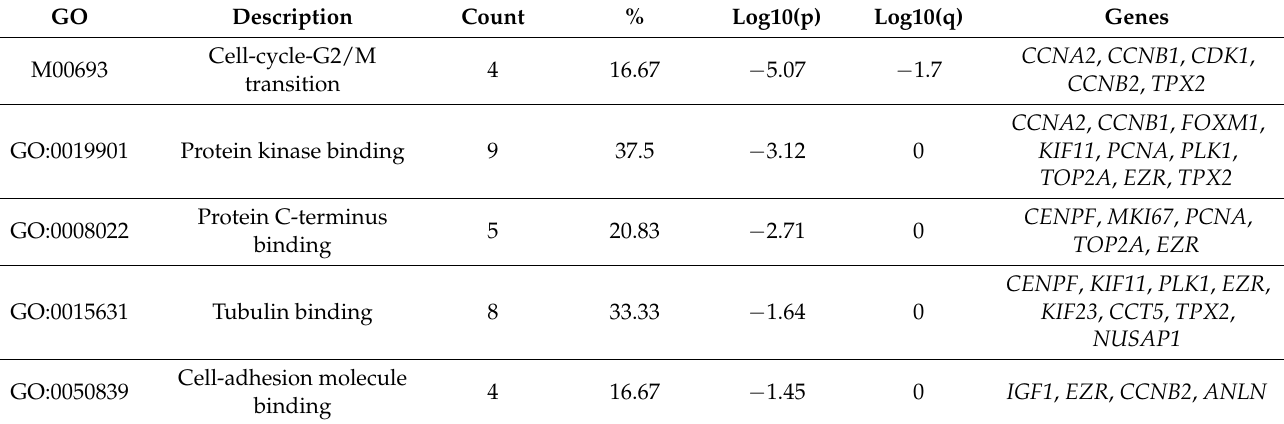
Table 4. Top 5 clusters with their representative enriched terms (one per cluster) cellular functions enrichment analysis. “Count” is the number of genes in the user-provided lists with membership in the given ontology term. “%” is the percentage of all of the user-provided genes that are found in the given ontology term (only input genes with at least one ontology term annotation are included in the calculation). “Log10(P)” is the p -value in log base 10. “Log10(q)” is the multi-test adjusted p -value in log base